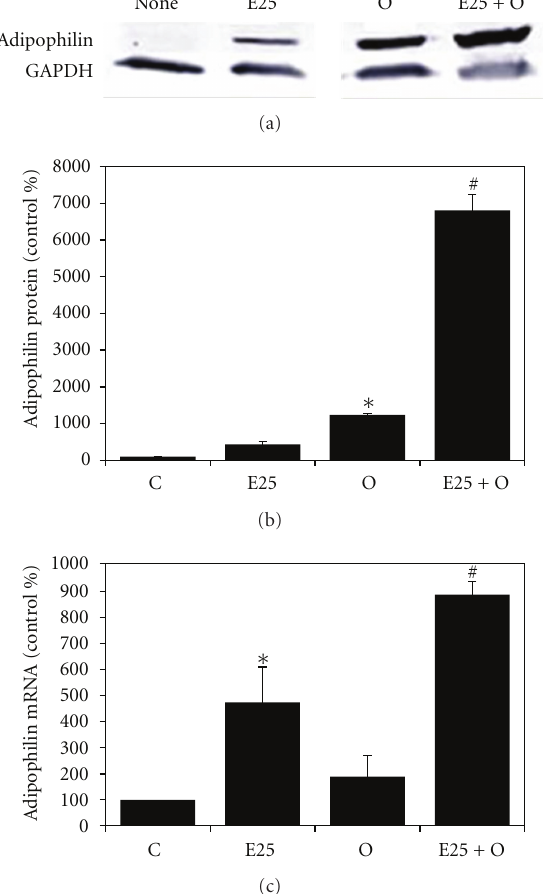
Figure 5: Adipophilin (ADRP) protein content and mRNA expres- sion in WIF-B cells. WIF-B cells were cultured for 48 hours in the absence (control media, C) or presence of 25mM ethanol (E25) with or without the presence of 0.5 mM oleic acid (O and E25 + O). (a) Representative Western blot indicating the presence of ADRP and glyceraldehyde-3-phosphate dehydrogenase (GAPDH) as the loading control. (b) Relative content of adipophilin protein expressed as percent of control from four independent experiments. (c) Adipophilin mRNA expression detected in the WIF-B cells. ∗ Significantly di ff erent ( P < 0 . 05) from control group and E25 group. # Significantly di ff erent from all other groups (C, E25, and O).